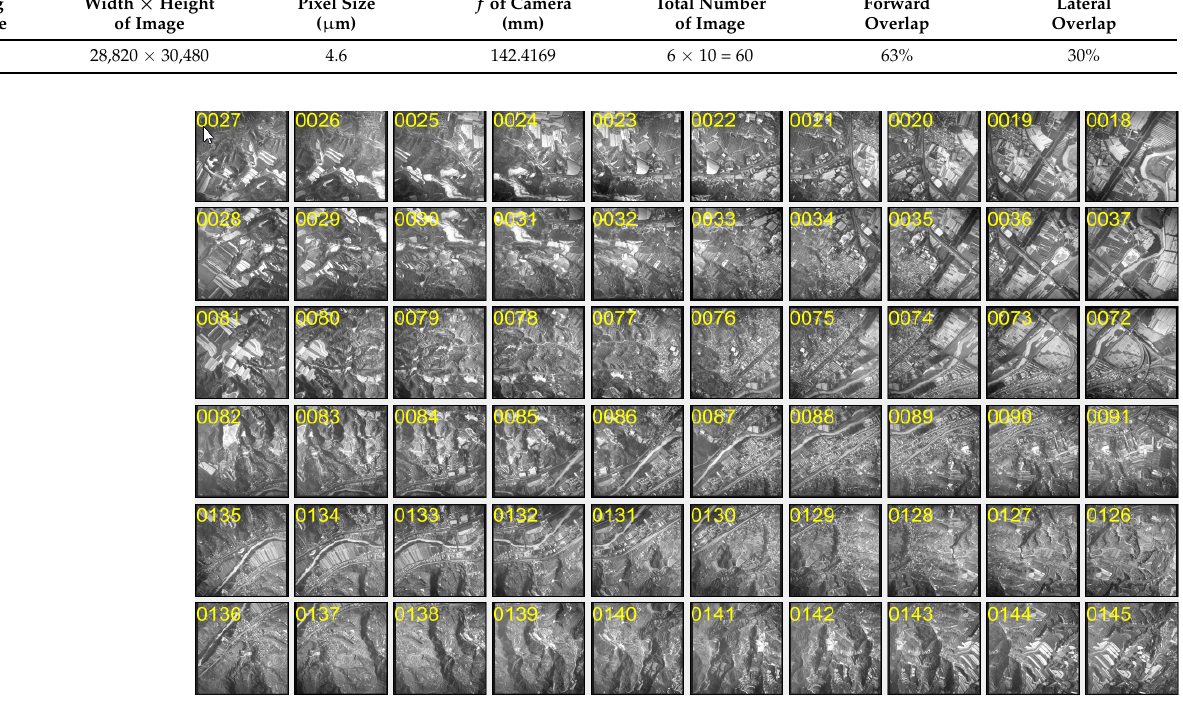
Figure 7. Images from a real surveying area. The western part of the survey area is a typical loess plateau landform with ravines and ravines and the terrain is very complex and contains many special texture images. The yellow number indicates the image